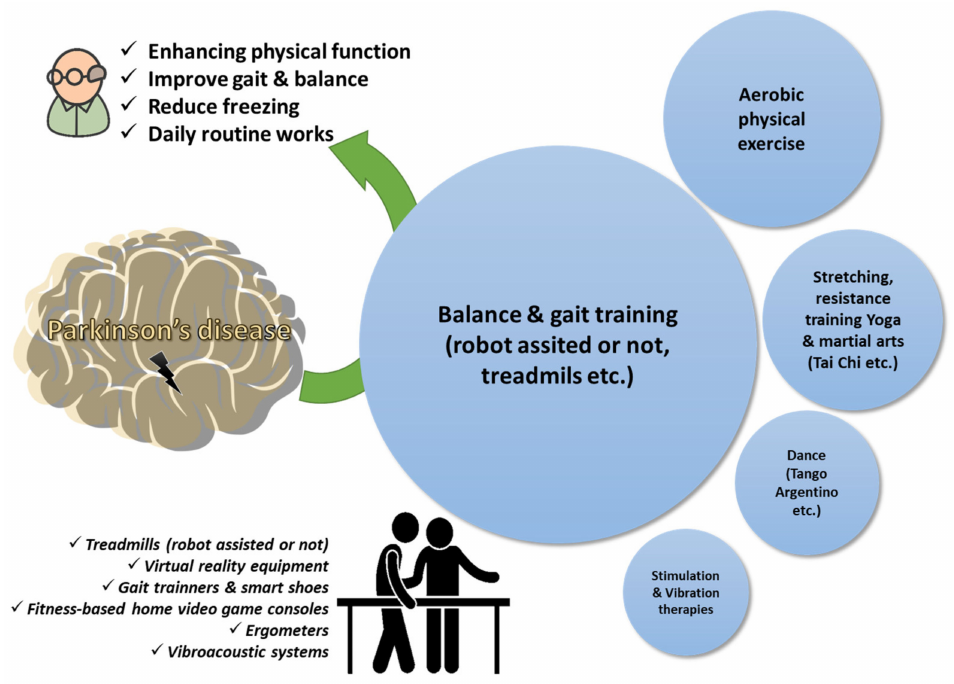
Figure 2. Physiotherapy goals in Parkinson’s disease. A qualitative infographic of clinical trials in the literature regarding physiotherapy approaches in elders managing Parkinson’s disease with the incorporation of several pieces of state-of-the-art